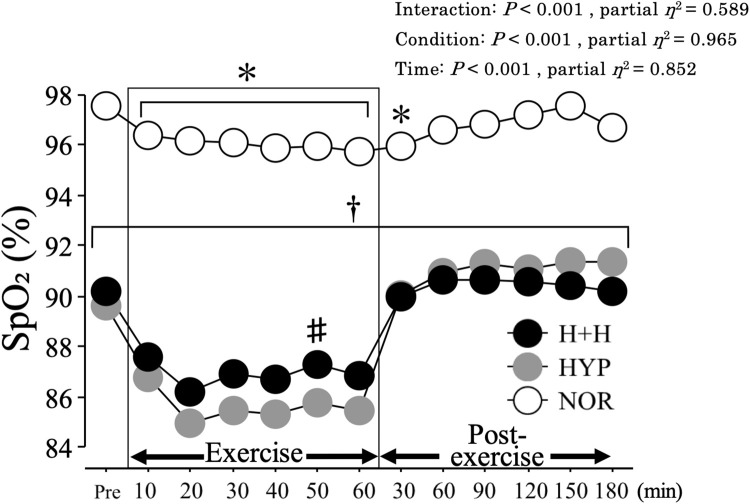
SpO2 during exercise and post-exercise. Values are means ± SE. ∗P < 0.05 vs. Pre. †P < 0.05 vs. NOR. #P < 0.05 vs. HYP. Shadow box indicates exercise duration.